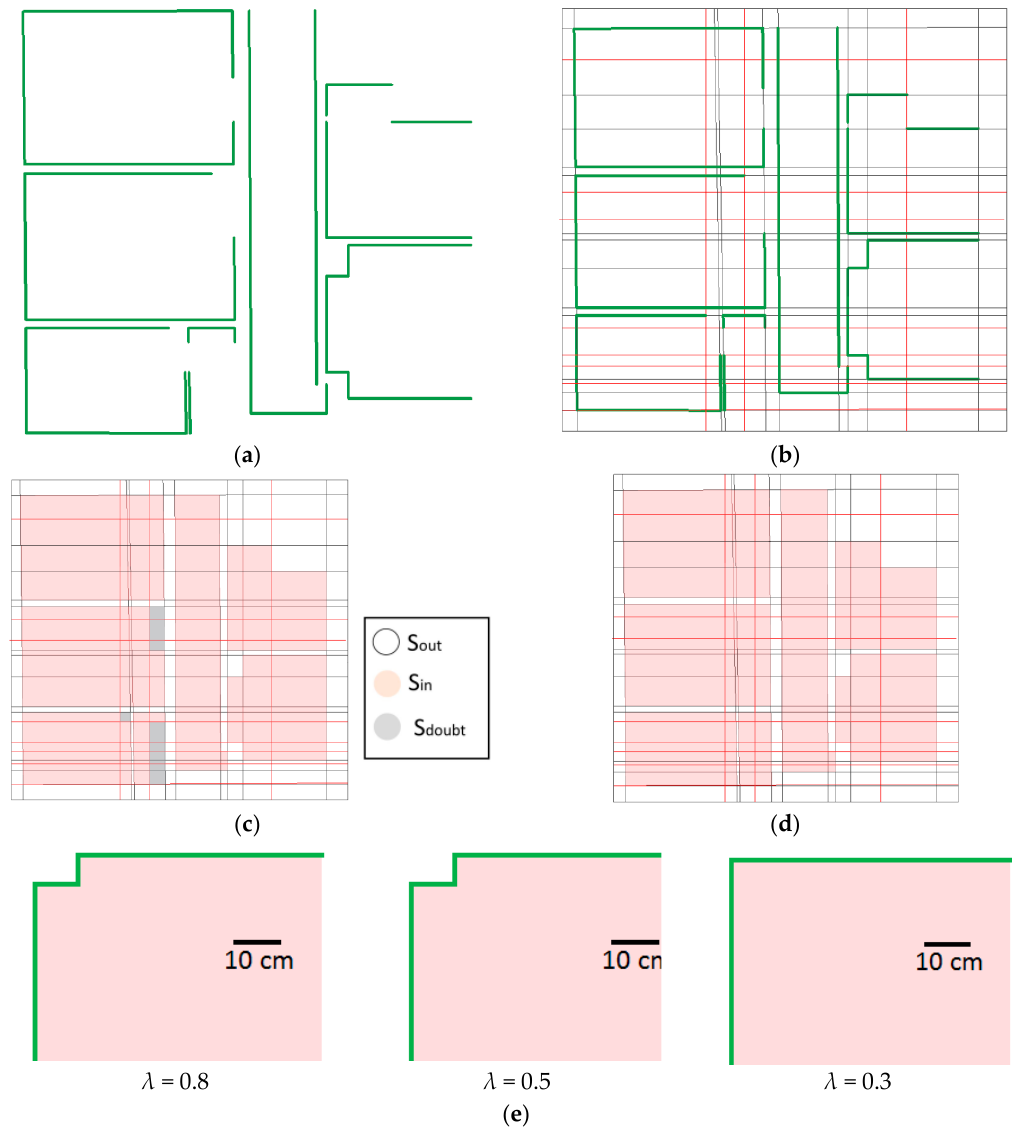
Figure 12. ‘Cell complex’ reconstruction for the adopted data set: ( a ) detected primitives; ( b ) induced ‘cell complex’ with ‘pending walls’ (red); ( c ) initial labeling of the ‘cell complex’; ( d ) final labelling ( λ = 0.8); and a detail of the complex with different values of λ ( e ).